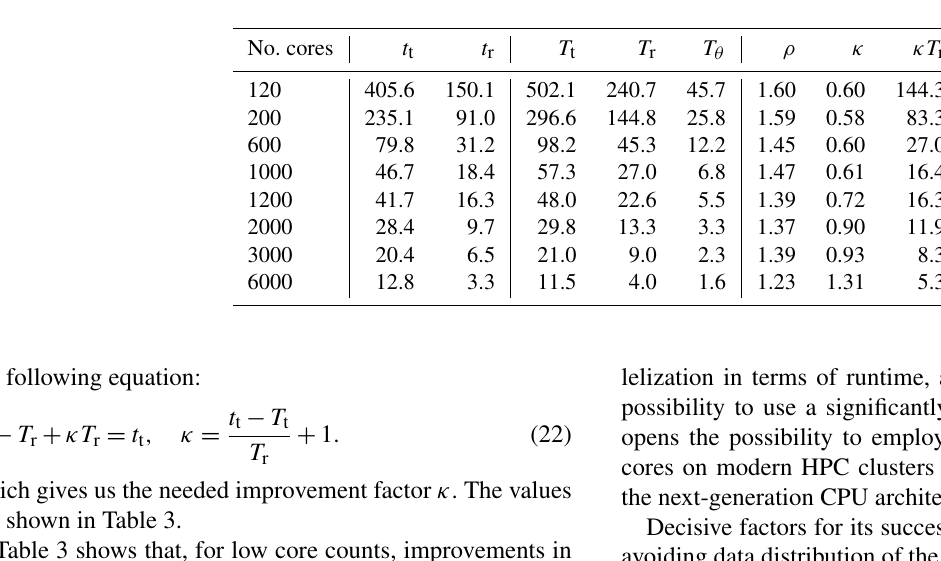
Table 3. Radial loop performance comparison for the dynamo benchmark. t t ( T t ) is the main application time for the 1d-hybrid (2d-MPI) implementation. t r ( T r ) is the computation time for the radial loop of the 1d-hybrid (2d-MPI) implementation, and T θ is the time for the θ transposition in the 2d-MPI implementation. All times are given in seconds. The columns ρ and κ are defined in Eqs. (21) and (22),